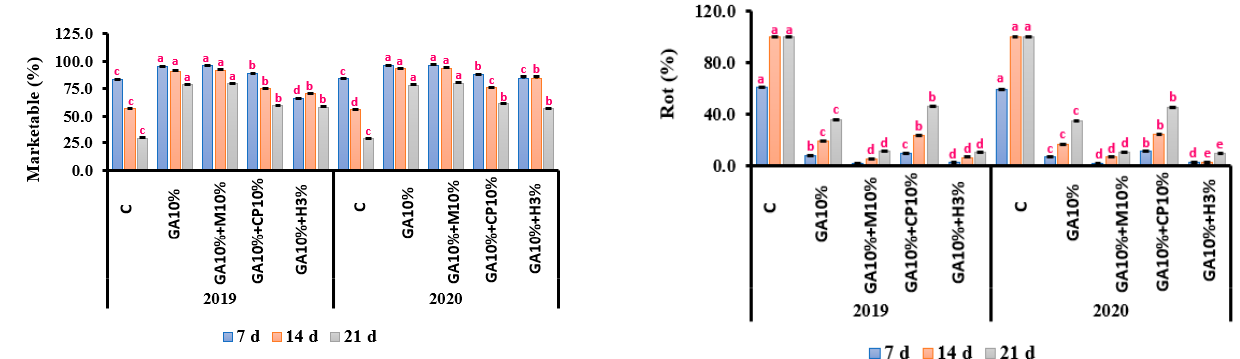
Figure 1. Effect of edible coatings of moringa extract, cactus pear, and henna, and GA, on weight loss, decay, rot, and marketable percentages of guava fruits during cold storage for 21 days throughout two seasons (2019–2020). The superscript letters, present the significantly between effect of treatments using Duncan’s multiple range tests.